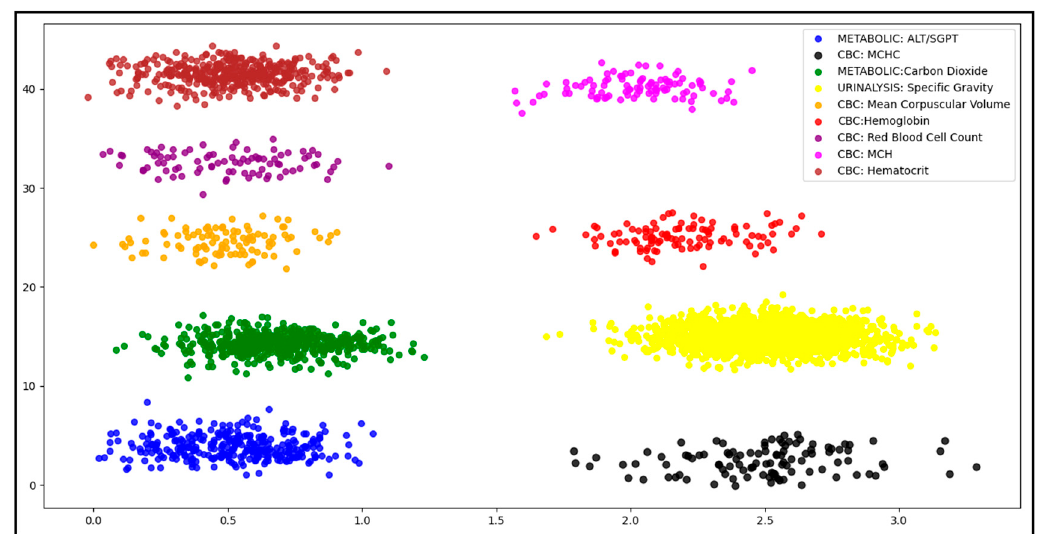
Figure 5. Lab test subclusters.